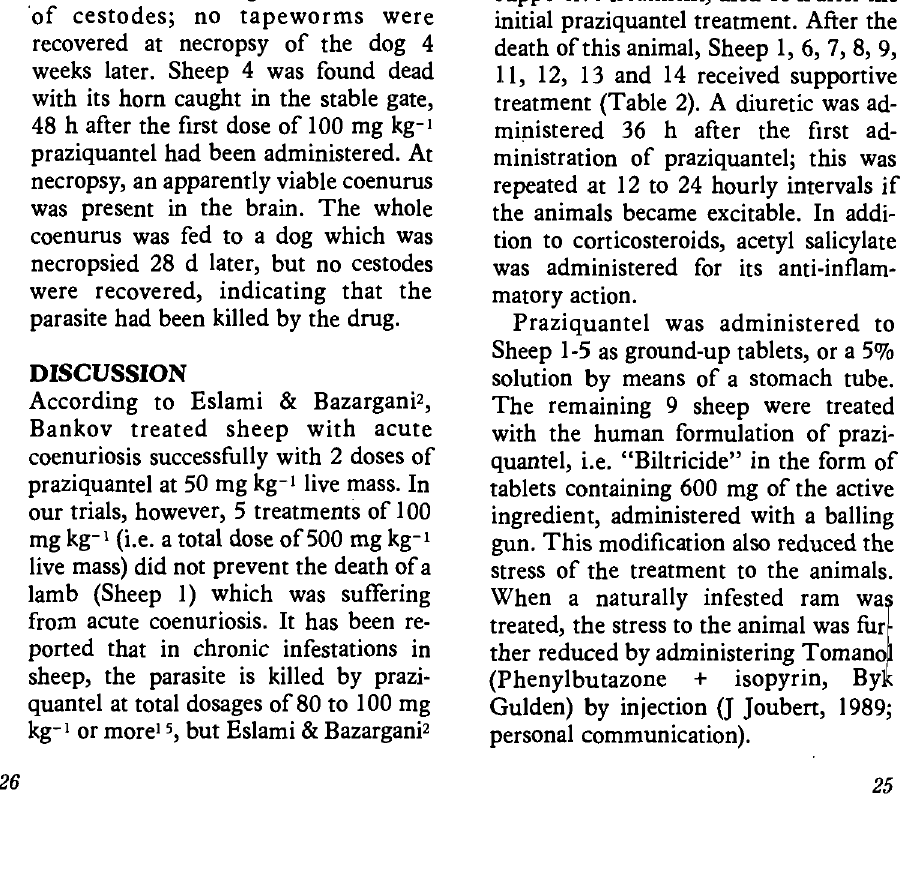
Corticosteroid Acetylsalicylate Furosemide